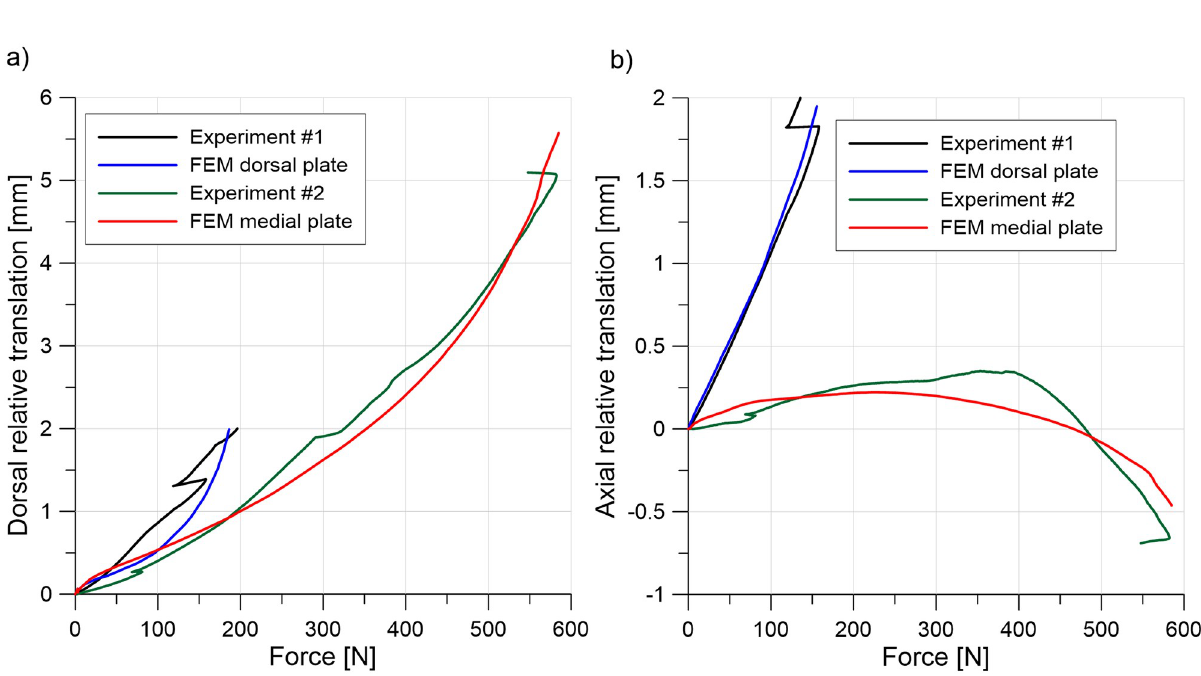
Fig 7. Validation of dorsal (a) and axial (b) translations of point P1 relative to point P2 for dorsally and medially positioned plates.